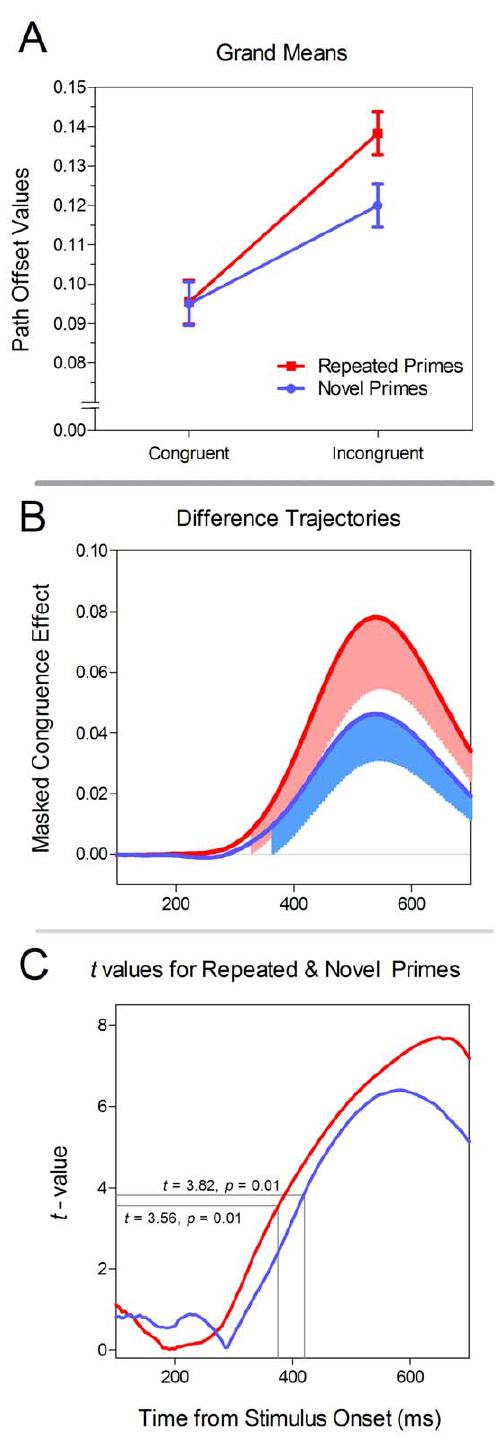
Figure 5. Results from Experiment 1. In Panel A, the grand means by Prime Type and Prime Congruence are depicted. In Panel B, the difference trajectories (incongruent – congruent) are depicted for each Prime Type. The shaded regions indicate 95% confidence intervals that do not include zero (i.e. a significant MCE). Panel C depicts the observed t -values for each Prime Type. The critical t -values are indicated with grey lines.